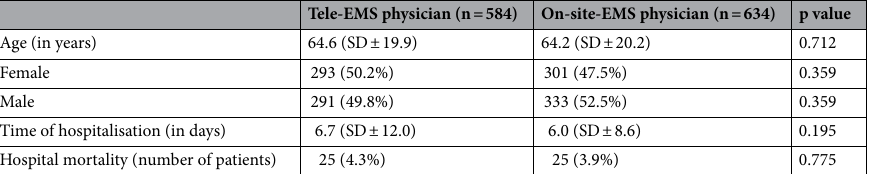
Table 1. Demographic data. This table shows demographic data as well as the time of hospitalisation and mortality from patients treated by the tele-EMS physician in comparison to patients, treated by the on-site- EMS physician. The probability of a type 1 error below 1% was considered as significant.